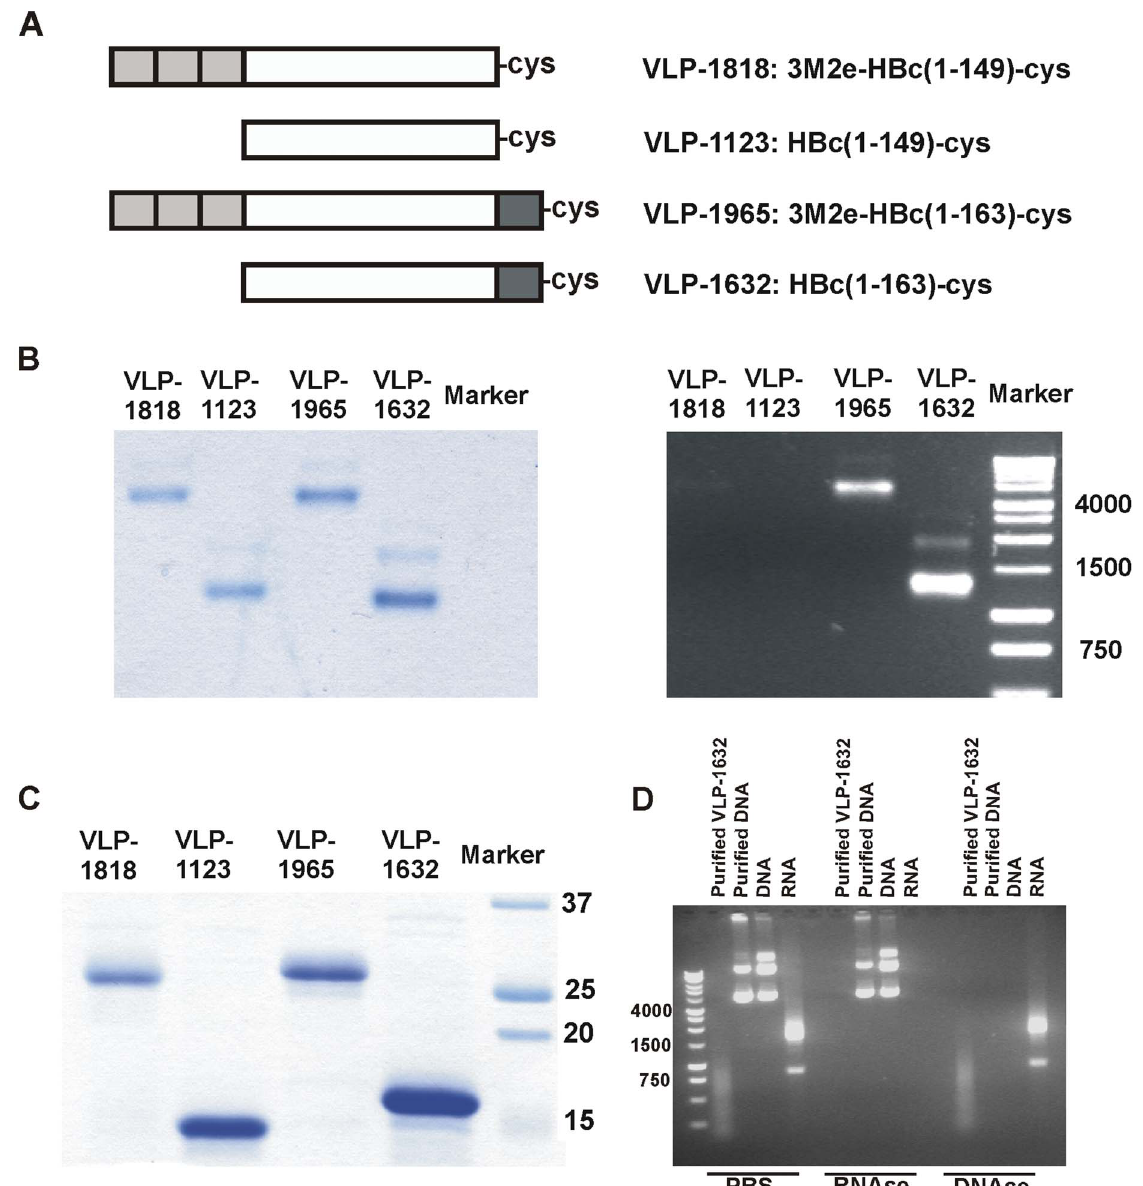
Figure 1. The C-terminal arginine-rich domain of recombinant HBc-based VLPs binds nucleic acids. A . Schematic representation of the recombinant M2e-VLPs and control VLPs used in this study. Light grey boxes on the left in VLP-1818 and VLP-1965 represent three tandem M2e copies; white boxes represent HBc amino acid residues 1–149; dark grey boxes on the right in VLP-1965 and VLP-1632 represent part of the arginine- rich domain of HBc (residues 150–163). In all constructs, a C-terminal cysteine residue (cys) was engineered to improve particle stability. B . Native agarose gel analysis of VLPs, followed by staining with Coomassie Brilliant blue (left) or ethidium bromide (right). C . Purified recombinant VLPs (2 m g each) were separated by SDS-PAGE and stained with Coomassie Brilliant Blue. D . VLP-1632 contains RNA. One m g of nucleic acids purified from VLP- 1632, similarly purified plasmid DNA, plasmid DNA and total mammalian cellular RNA were treated with either PBS, RNAse or DNAse and analyzed by agarose gel electrophoresis followed by SYBR Safe staining. Numbers on the left indicate sizes in base pairs of the DNA marker in the left hand